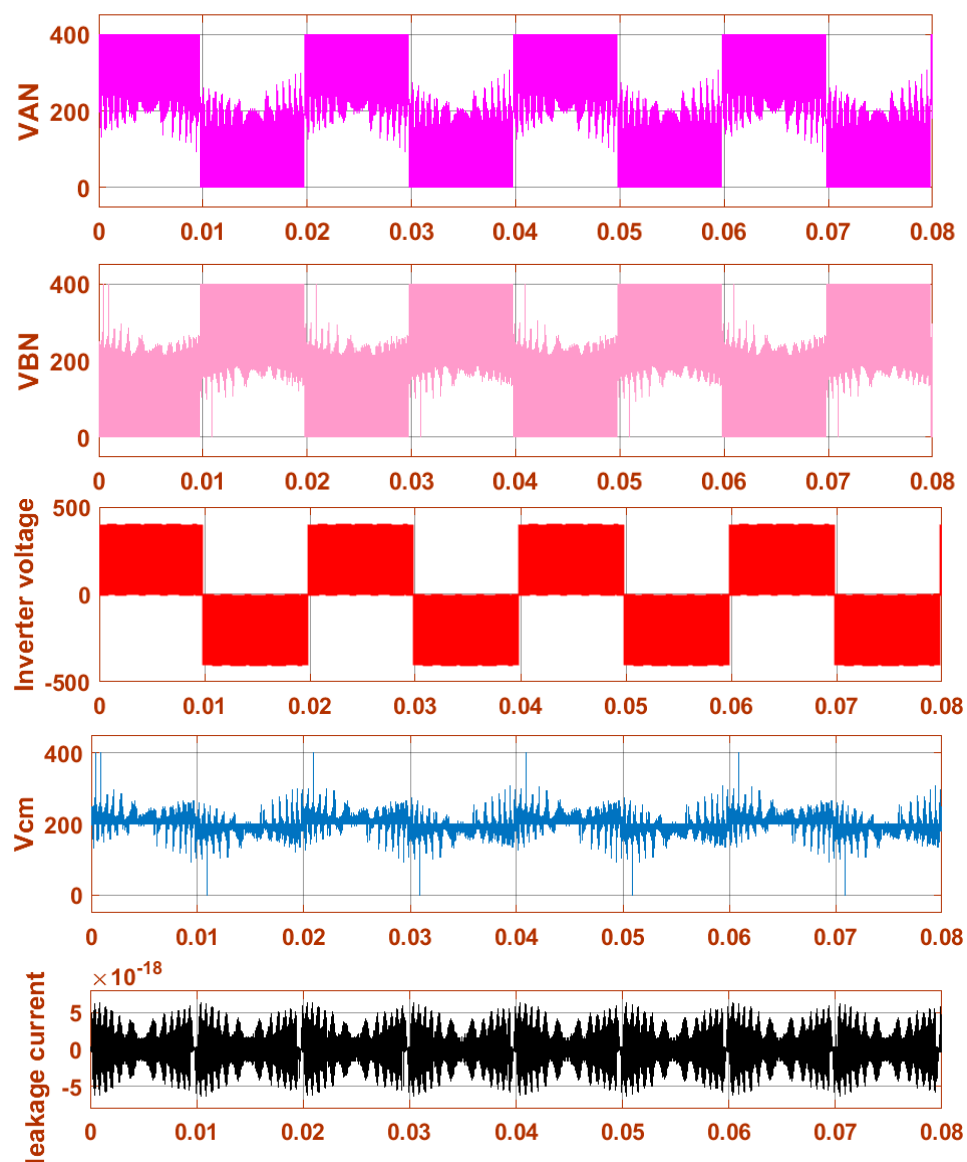
Figure 16. Waveform of V AN , V BN , inverter voltage and V cm , leakage current of H6 III inverter.